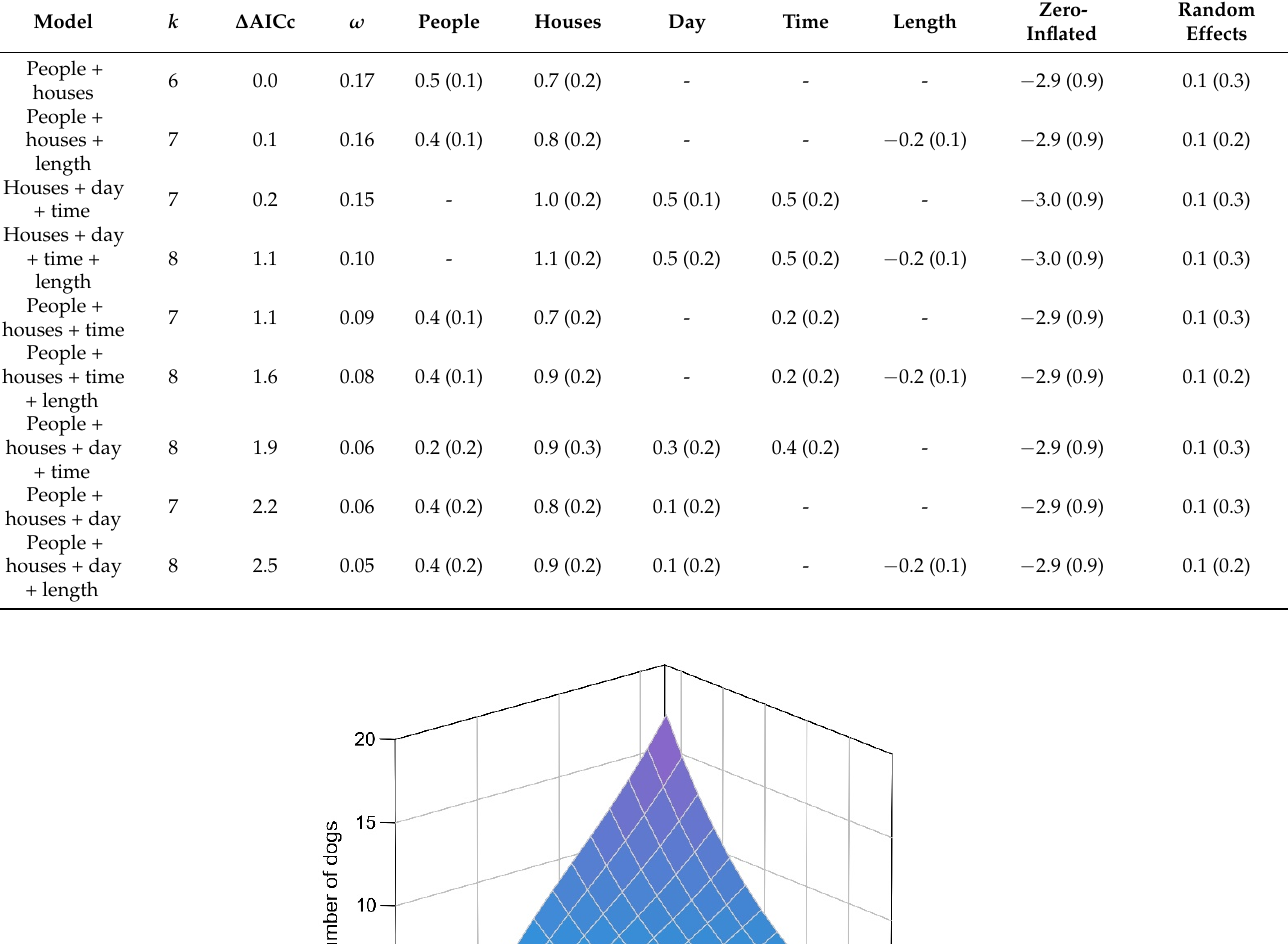
Table 2. Models that explain the number of dogs detected at sandy beaches of southern Chile. Candidate models with little support ( ω < 0.05) are not shown. The data presented include the number of parameters ( k ), delta Akaike Information Criterion corrected for small sample size (AICc, ∆ AICc), Akaike weight ( ω ), and the parameter estimates and standard errors (in parentheses) for the effects of number of people on the beach (People), number of houses in surrounding areas (Houses), day (Day, week day as reference), time (Time, morning as reference), and beach length (Length) on the Poisson component of the model, and the effect of number of people on the zero-inflated component of the model (Zero-inflated). The random effect variance (Random effects) and its standard deviation in parentheses are also shown.